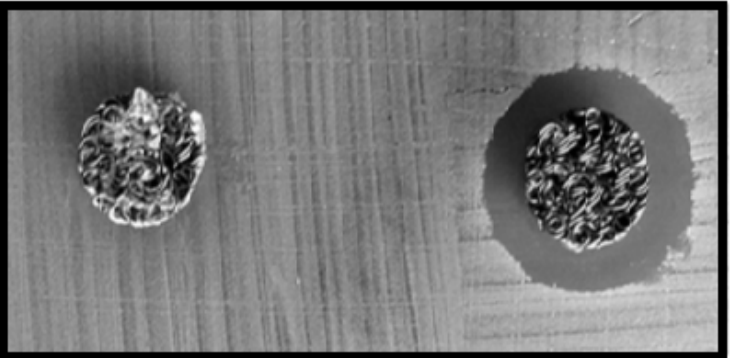
Figure 20. Antibacterial test of GS-loaded Ti-G after 24 h [67]. Reprinted with permission from ref. [67]. © 2016 Elsevier.